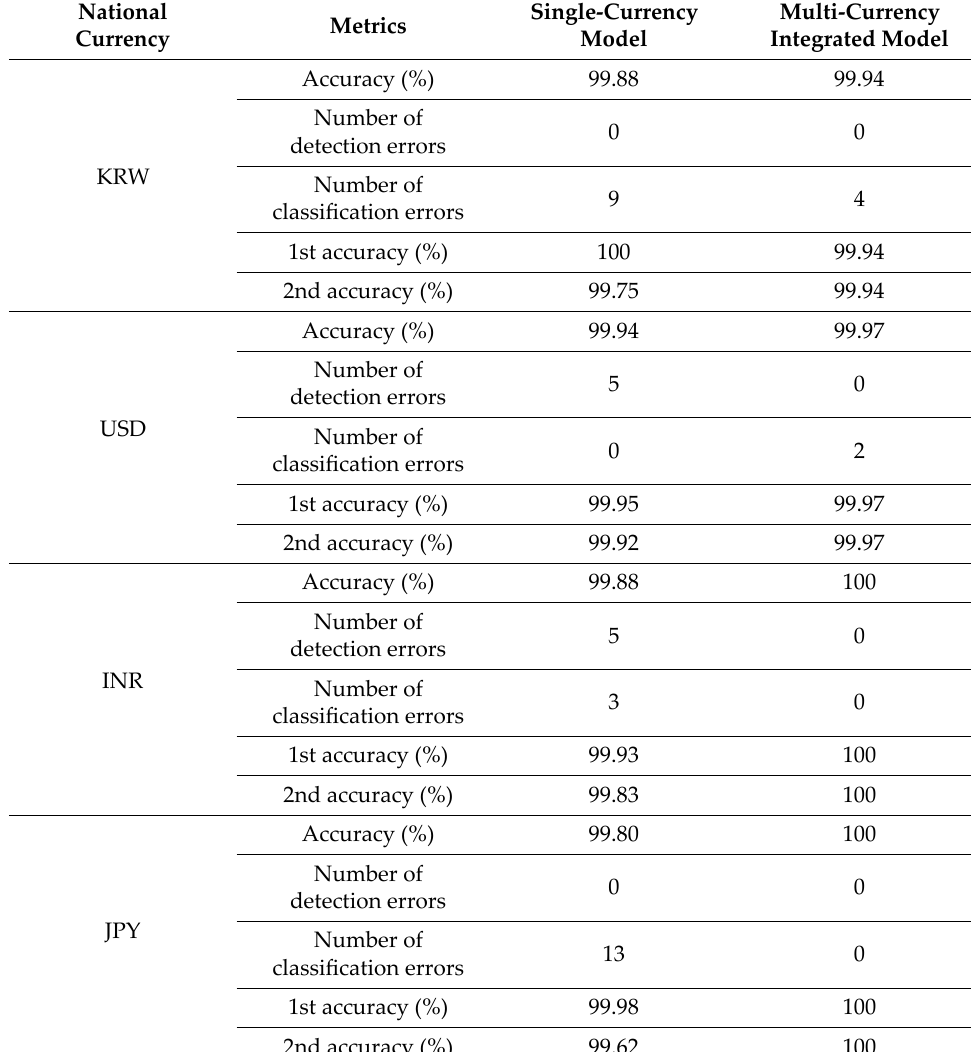
Table 6. Performance comparison of the single‑currency dataset‑based and multi‑currency dataset‑ based